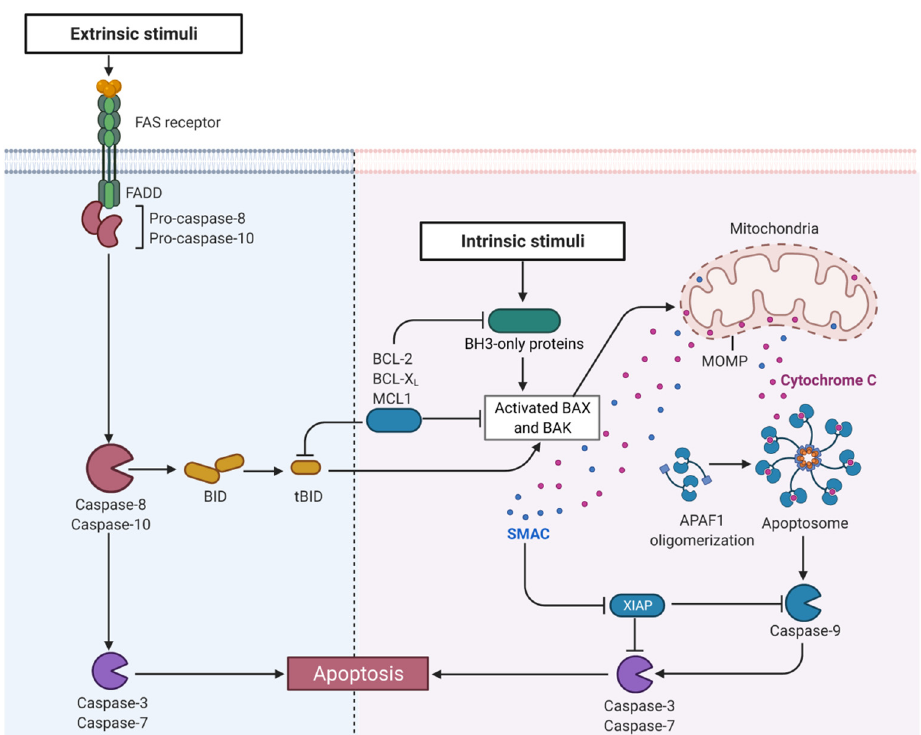
Figure 3. Mitochondria regulate apoptosis in UC. Abbreviations: APAF1, apoptotic prote- ase-activating factor 1; BAK, Bcl-2 homologous antagonist/killer; BAX, Bcl-2-associated X protein; BCL, B-cell lymphoma; BH3, Bcl-2 homology domain 3; BID, BH3 interacting domain death agonist; FADD, Fas-associated via death domain; MCL1, myeloid leukemia cell differentiation pro- tein-1; MOMP, mitochondrial outer membrane permeabilization; SMAC, the second mitochon- dria-derived activator of caspases; XIAP, X-linked inhibitor of apoptosis. The figure was created with BioRender.com.